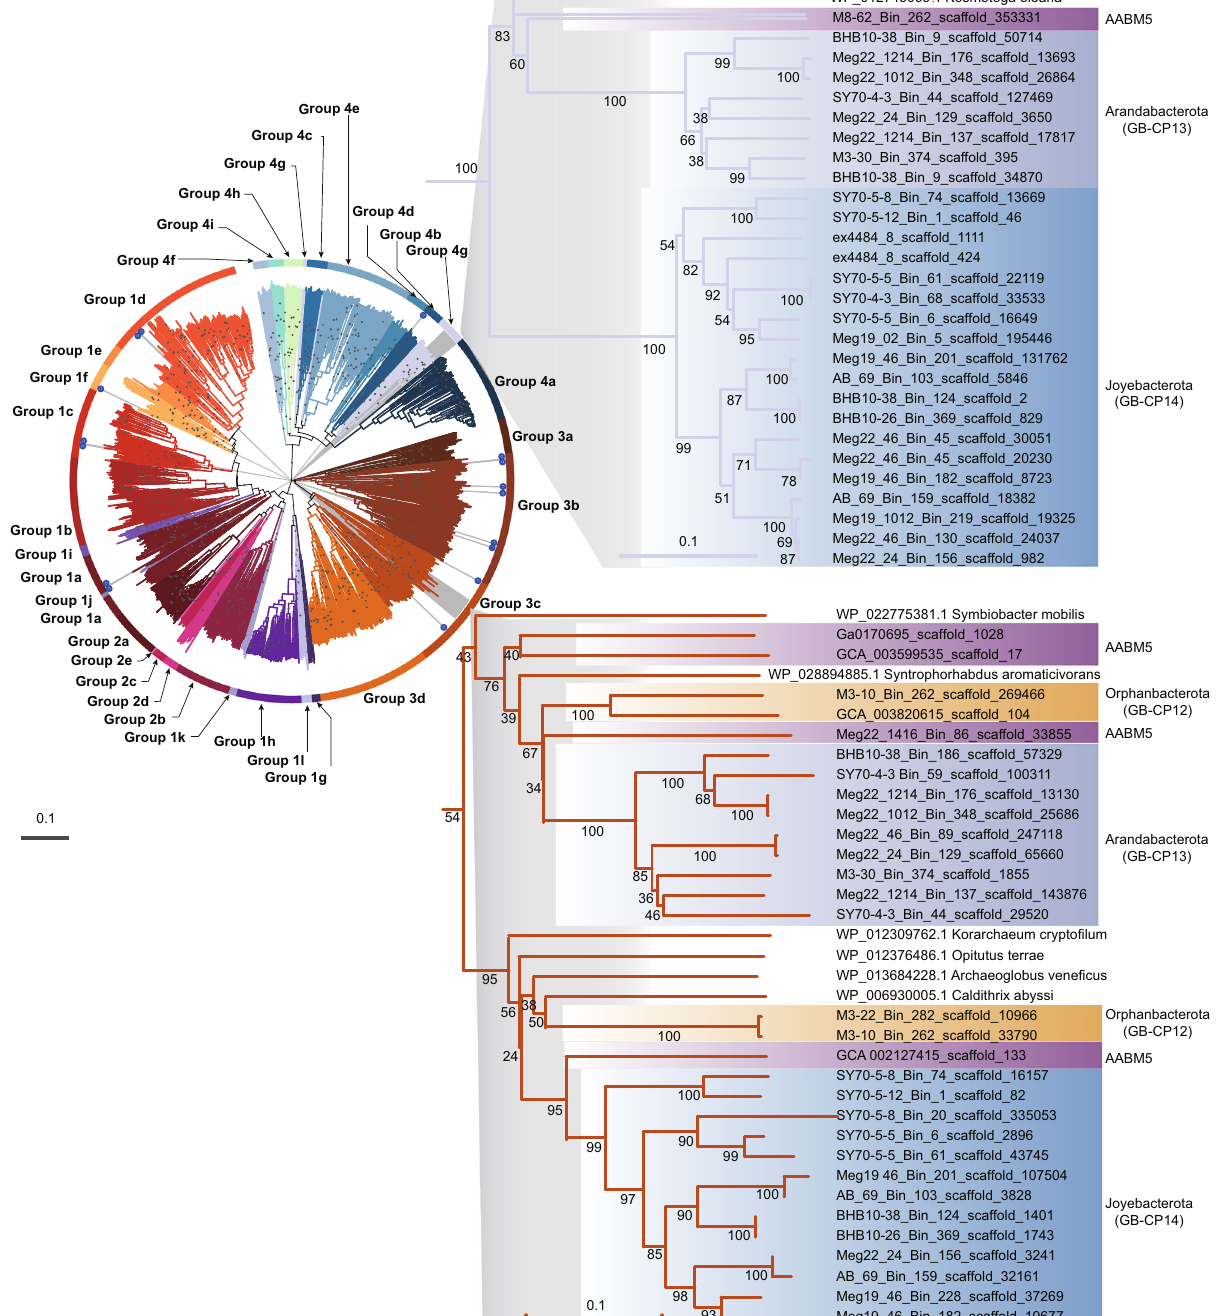
Fig. 3 | Maximum likelihood phylogenetic tree of NiFe hydrogenases from the novel phyla. The majority of NiFe hydrogenases identi fi ed from the fi ve phyla in thisstudyarehighlighted inthegraybackground.Mosthydrogenasesaretypes4g